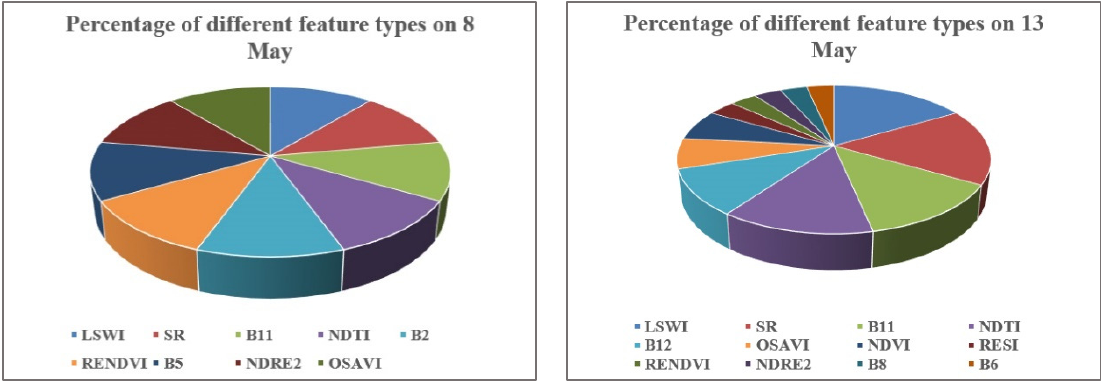
Figure 8. Percentage of different character types of rice in 2020 different periods.